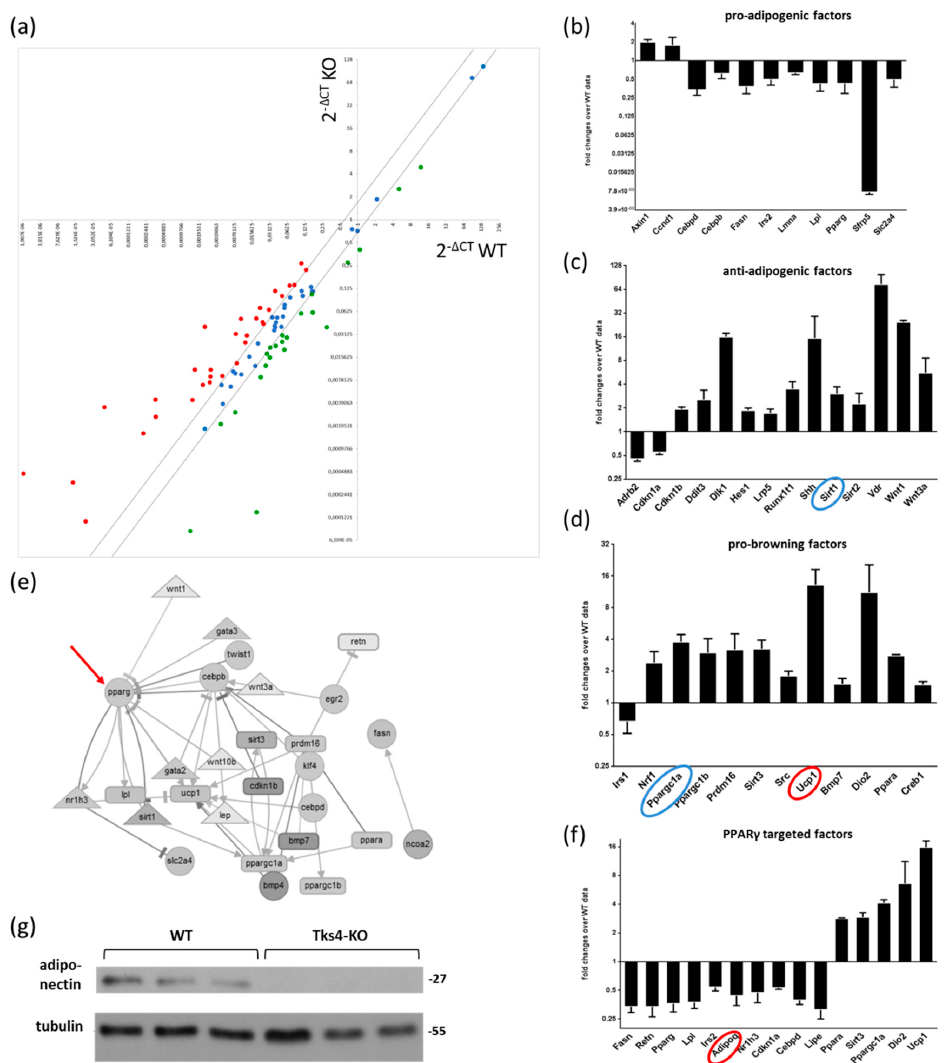
Figure 4. The e ff ects of Tks4 loss on the expression levels of adipogenesis-related regulatory genes. ( a ) Scatter plot showing the up- and downregulation of the investigated gene set. Each dot represents the expression level of a given gene in WT gWAT (the x axis represents the WT Δ CT) and in Tks4-KO gWAT (the y axis represents the Tks4-KO Δ CT). The two black lines represent the threshold fold change cut-offs at ±1.5. The black lines demarcate the genes with unchanged expression levels (blue dots), and the red-labeled and green-labeled dots represent the up- and downregulated genes, respectively, in the Tks4-KO gWAT (see the gene list in Table S1). The relative expression levels of the genes belonging to the pro-adipogenic factor group ( b ), the anti-adipogenic factor group, ( c ) and the pro-brown factor group ( d ) are shown in separate plots. The blue circles highlight a cofactor ( PPAR γ C1a ) and a corepressor ( Sirt1 ) of PPAR γ . The expression levels of the genes marked with red circles were verified via western blotting and immunohistochemical (IHC) analysis. The mRNA levels measured in the WT samples were set to 1, and the fold changes in the gene expression levels in the Tks4-KO samples were calculated. ( e ) An interaction network of the di ff erentially regulated genes. The black arrows represent activating relationships, and the blunt-end lines represent inhibitory relationships among the factors. The red arrow indicates PPAR γ as the most highly connected node. ( f ) The relative gene expression levels of the PPAR γ -targeted genes. The gene expression fold changes were calculated via the ∆∆ CT method. ( g ) The adiponectin protein level was measured via western blotting to validate the change in the mRNA level detected on the array. The adiponectin protein level was measured in three WT and three Tks4-KO gWAT samples, and tubulin was used as the loading